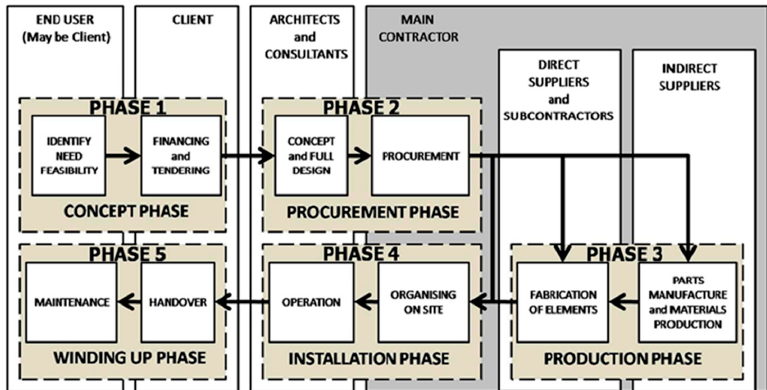
Figure 1. Current procurement structure (Broft et al. [33]; reprinted with permission: Emerald).